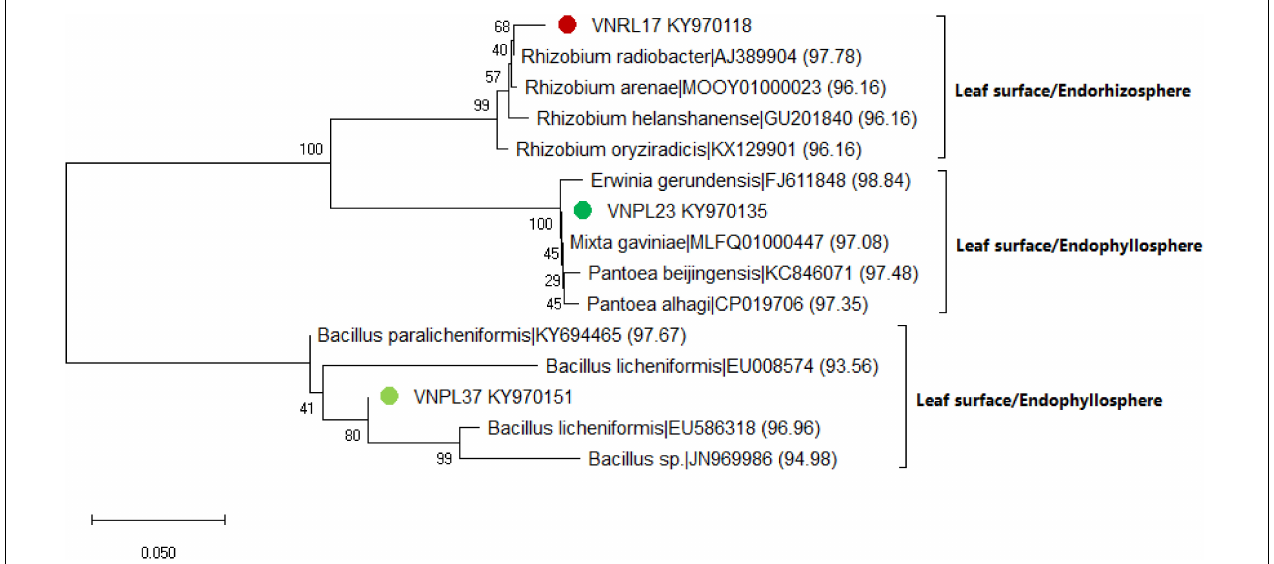
FIGURE 6 | Maximum likelihood (ML) phylogenetic tree of the bacterial isolates recovered by the leaf surface-inoculation method from the endorhizosphere (VNRL17) and endophyllosphere (VNPL23, VNPL37) of sunflower plants, based on 16S rRNA gene sequences. Bootstrapping was performed for each tree with 1000 replicates; the percentage of trees in which the associated taxa clustered together is shown next to the branches; numbers between brackets refer to the similarity percentage according to the EZBiocloud database.